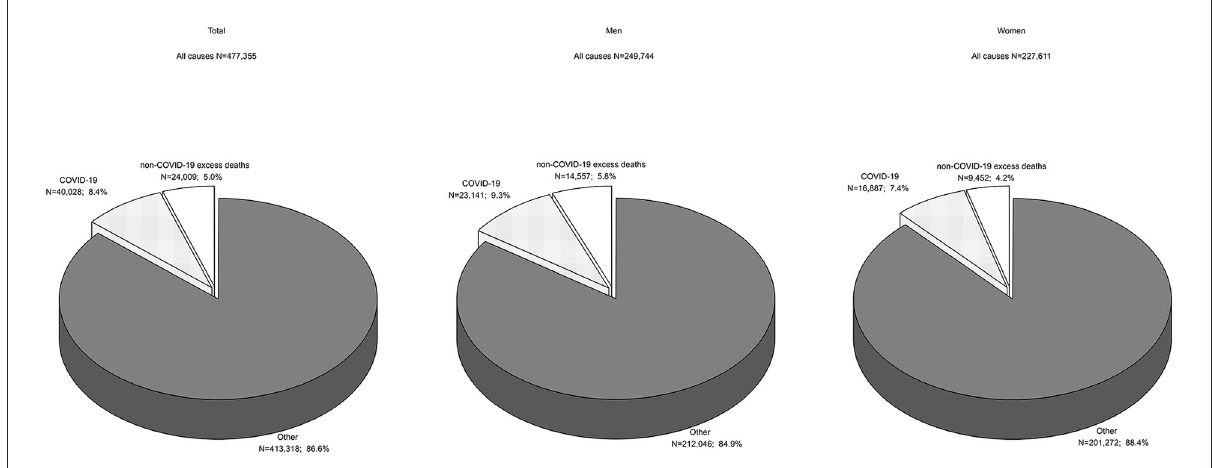
FIGURE2 Excess mortality in 2020 due to COVID-19 and non-COVID-10 causes in total and by gender.